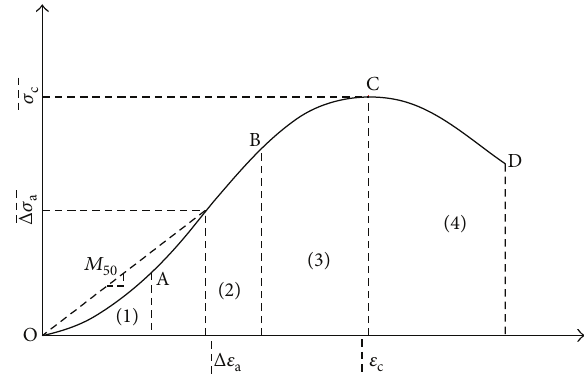
Figure 1: Typical compressive stress-strain curve of simulated soft